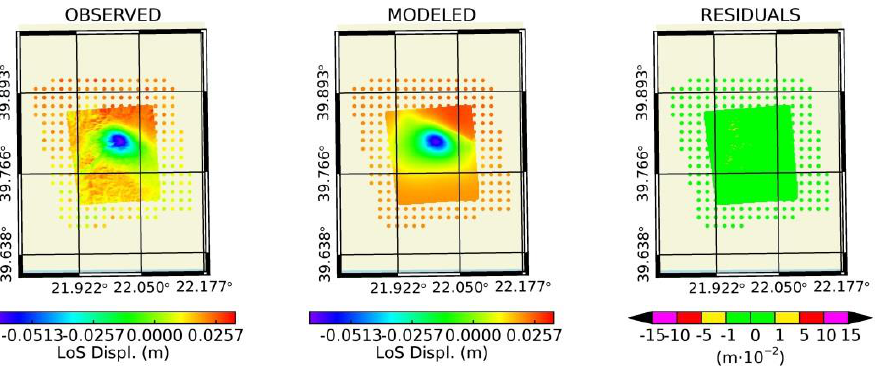
Figure 21. Comparison of LoS displacements from observed and modeled data for the third earthquake (12 March 2021) using the descending mode.